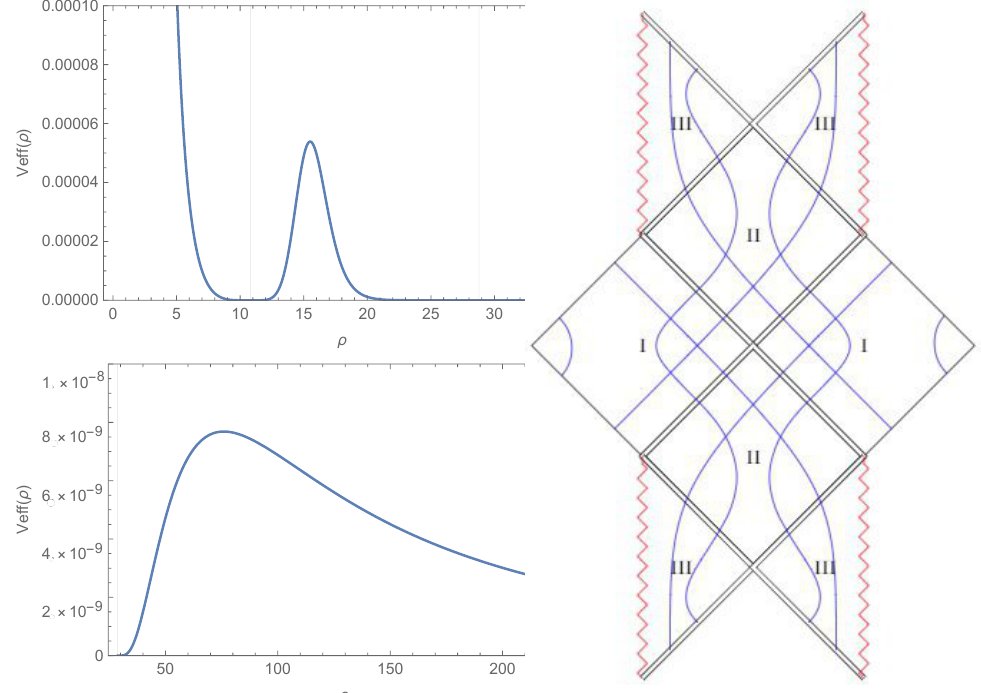
Figure 1. Plot of the Effective potential for massless particles for the first solution, in the case where a assumes odd values ( left-top figure), and a zoom of the potential after the horizon ( left-bottom figure). The vertical lines in the left figure indicate the two event horizons of the solution. Moreover, the right figure is the Carter–Penrose diagram drawing for this case. The red lines are the singularities; the double lines are the horizons; the blue lines are the possible geodesic curves. The value of the parameters used were: λ = 27, k = 9, m = 30, and L =